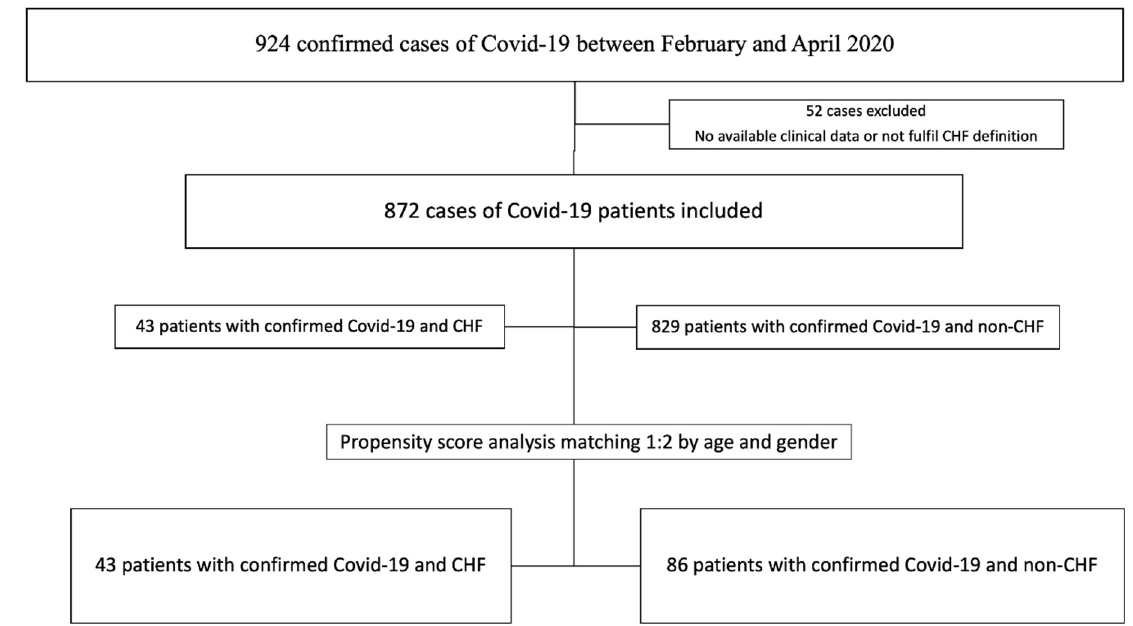
Figure 1. Flow chart of patient’s selection and propensity score matching. CHF: chronic heart failure.